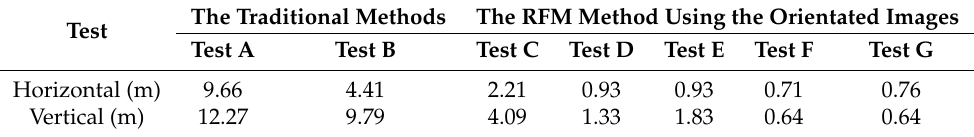
Table 8. Accuracies for IKONOS-Scene04 and IKONOS -Scene05 with traditional methods and the RFM